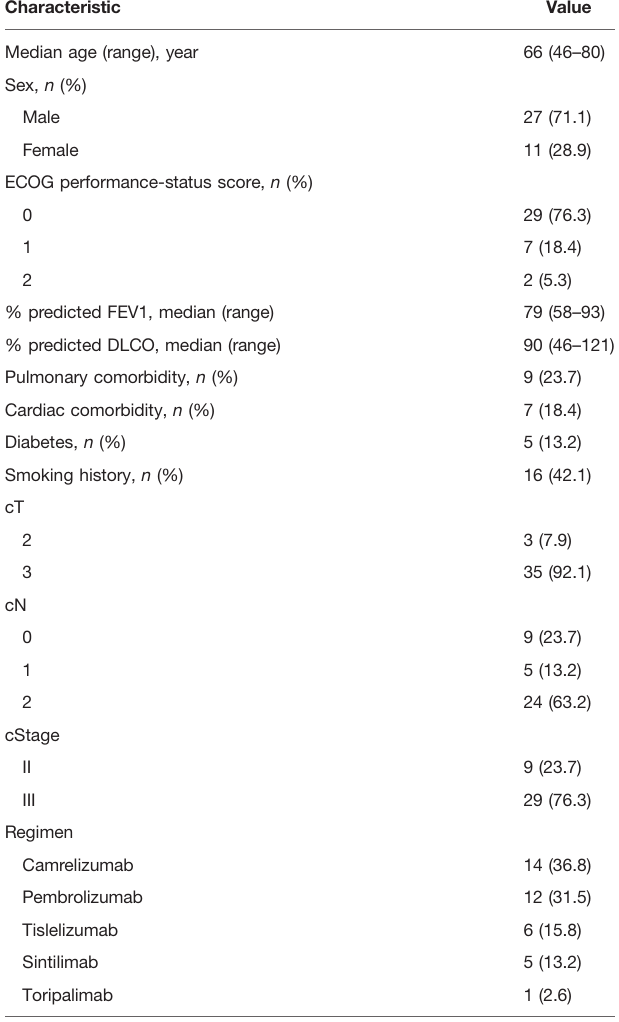
TABLE 1 | Patient characteristics ( n